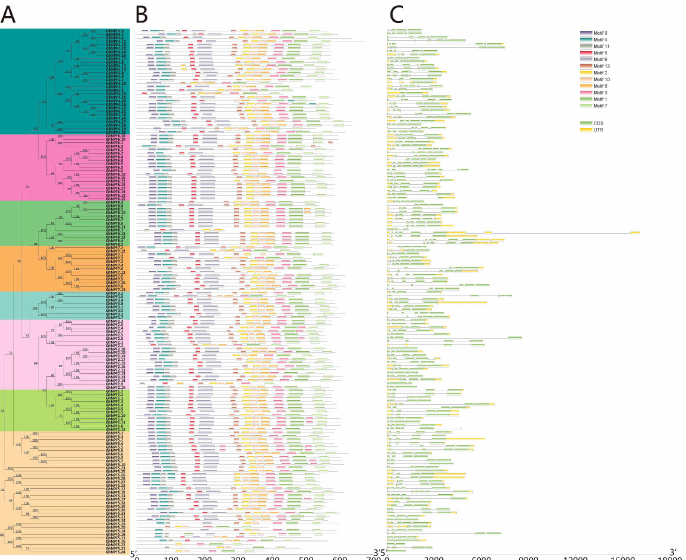
Figure 2. Conservative motifs and exon–intron organization of NPF gene family from Gossypium hirsutum. ( A ) Phylogenetic tree of NPF gene family obtained according to NJ method in MEGA software. ( B ) Conservative motifs of NPF proteins. The 12 conserved motifs in GhNPF proteins are indicated by multiple-colored boxes. ( C ) Exon–intron structures of NPF gene